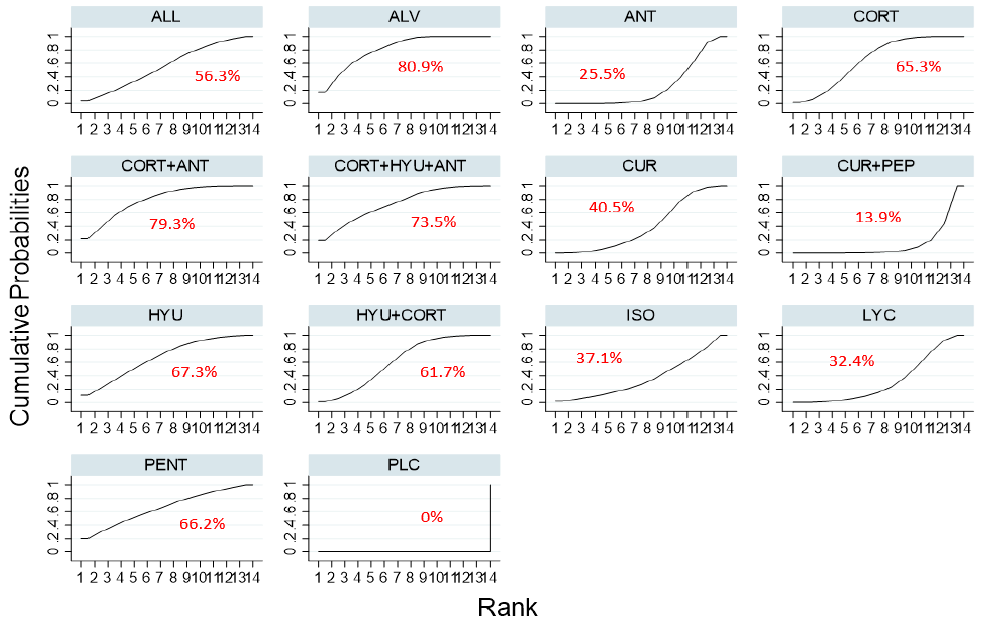
Figure 3. SUCRA ranking curve for the comparative efficacy of different interventions used in the management of OSMF (mouth opening). Abbreviations: HYU—hyaluronidase;